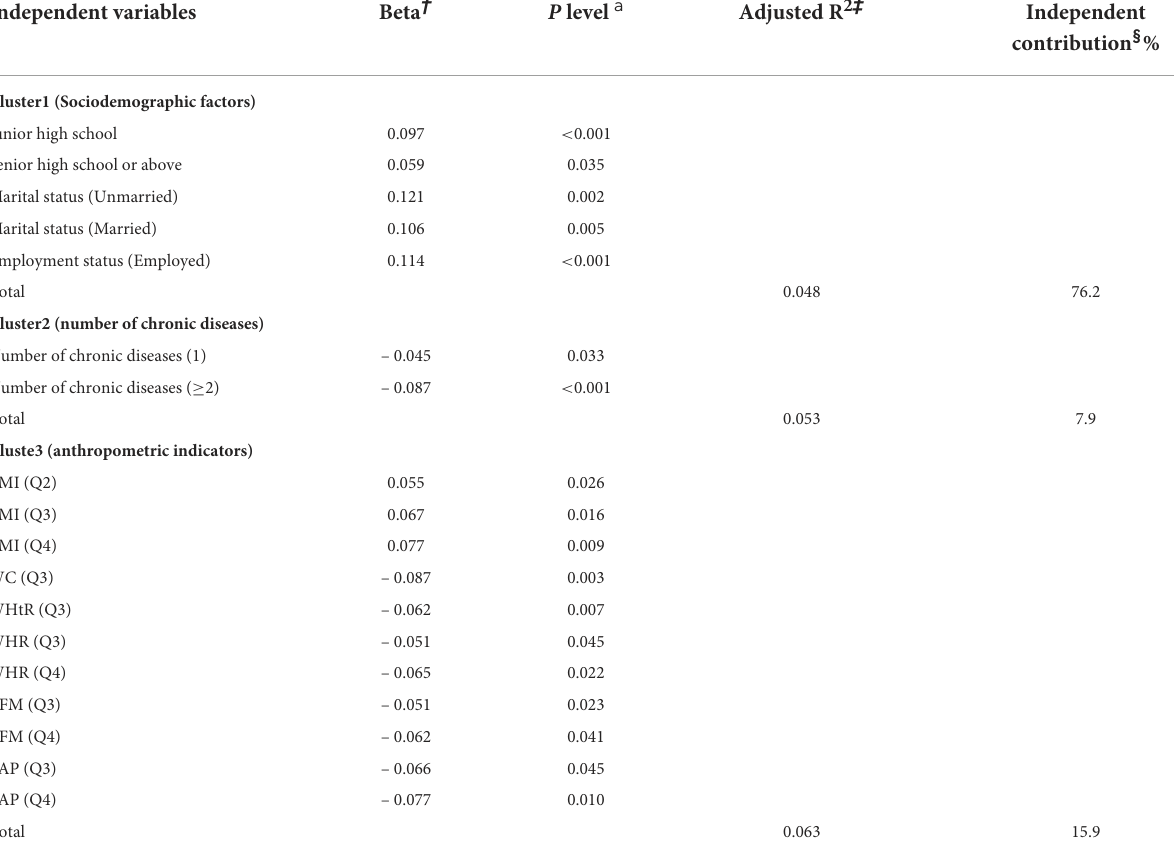
a P level:BasedonClusteredmultiplelinearregressionanalysis. † Betaisthestandardizedregressioncoefficientderivedfromthemultiplelinearregression,indicatingthechangeinstandardunitsofdependentvariableforeachincreaseofonestandard unitintheindependentvariable,controllingforallotherindependentvariables. ‡ AdjustedR 2 :istheproportionofvarianceinthedependentvariable(Utilityvalue)explainedbytheindependentvariablesincludedineachregressionmodel.